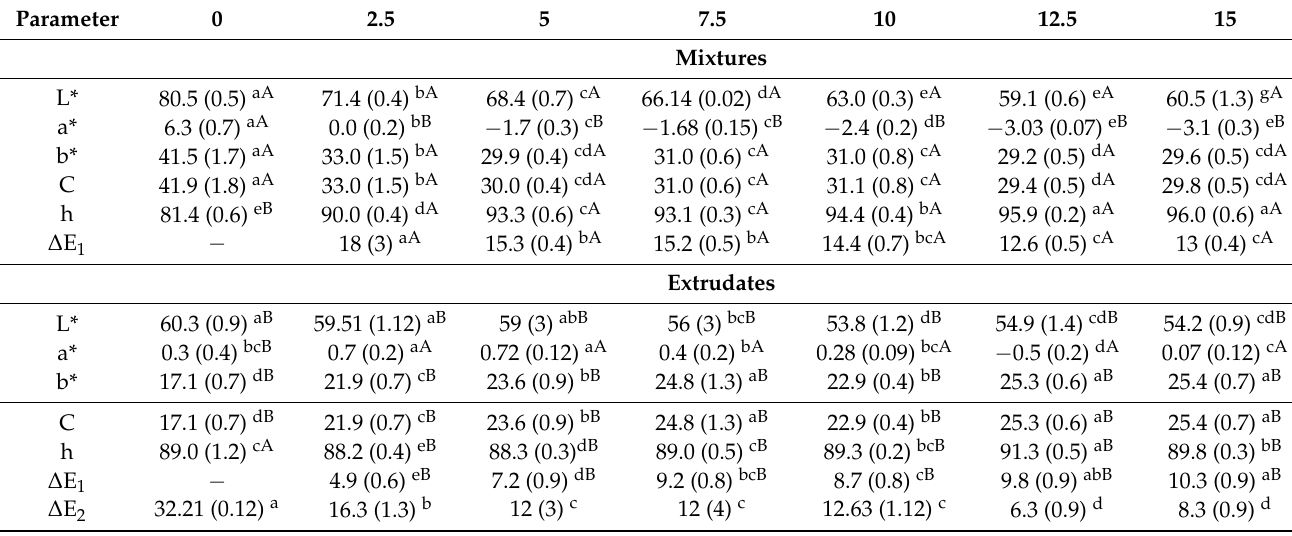
For each parameter, the same small letter in superscript within a row indicates homogeneous groups established by ANOVA ( p < 0.05) comparing MS percentages (0, 2.5, 5, 7.5, 10, 12.5, and 15) in mixtures or extrudates. For each MS percentages (0, 2.5, 5, 7.5, 10, 12.5, and 15) and parameter, the same capital letter in superscript within a column indicates homogeneous groups established by ANOVA ( p < 0.05) comparing mixtures and extrudates. L*(lightness), a* (red/green coordinate), b* (yellow/blue coordinate), C* (chroma), and h* (tone). All data represent the mean of three